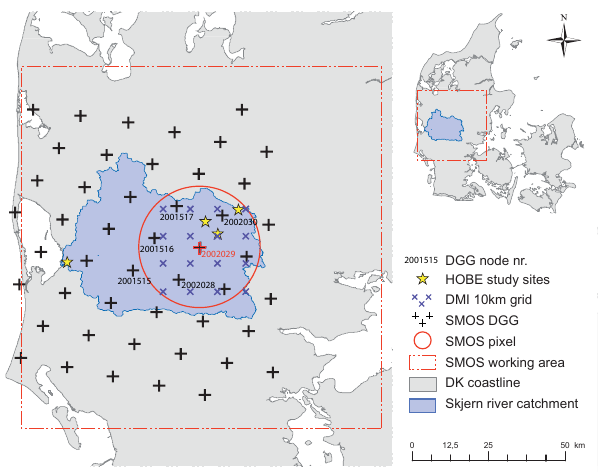
Fig. 1. Skjern River Catchment in Western Denmark, HOBE study sites, SMOS Discrete Global Grid (DGG) nodes including numbers of eligible nodes, selected SMOS pixel and corresponding working area around grid node 2002029, and DMI 10km precipitation grid within SMOS